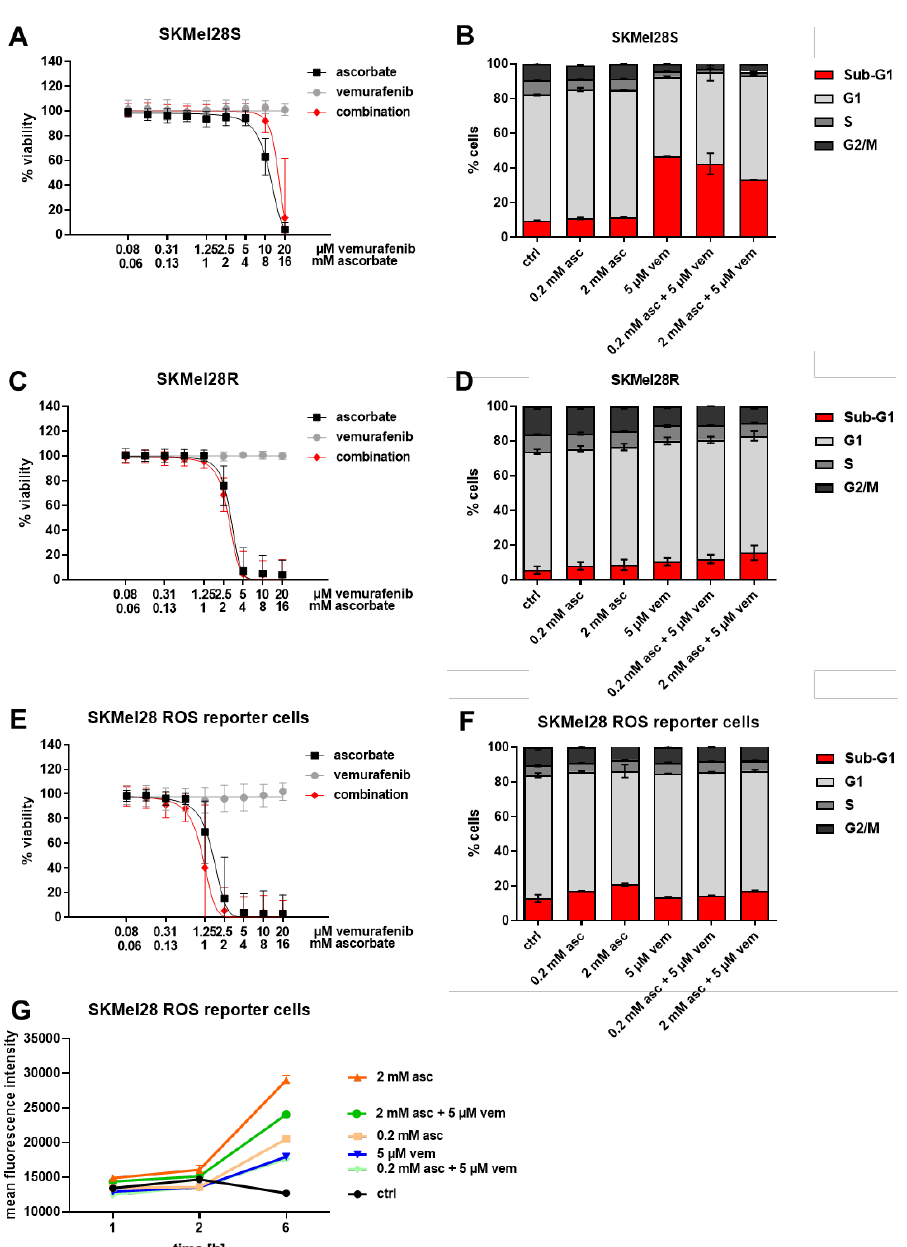
Figure 3. Effects of ascorbate and vemurafenib on viability, cell cycle distribution, and ROS production of melanoma cells. ( A ) SKMel28 S, ( C ) SKMel28 R, and ( E ) SKMel28 ROS reporter cells were treated with ascorbate, vemurafenib, and their combination. Depicted is the viability of treated cells compared to the untreated control. Shown are the mean values with standard deviations of three independent experiments, each measured in quadruplicates and normalized to the untreated control. ( B ) SKMel28 S, ( D ) SKMel28 R and ( F ) SKMel28 ROS reporter cells were treated with ascorbate, vemurafenib, and their combination. The cell cycle after PI staining was analyzed by flow cytometry. Shown are the mean values of each cell cycle fraction with standard deviations of three independent experiments, each measured in triplicates. ( G ) Flow cytometry measurement of the ratio Pacific Orange 405 nM/Alexa Fluor 488 nM, which resembles the amount of produced H 2 O 2 . SKMel28 H 2 O 2 reporter cells were treated with ascorbate, vemurafenib, and their combination. Shown are the mean values with standard deviations of three independent experiments, each measured in quadruplicates and normalized to the untreated